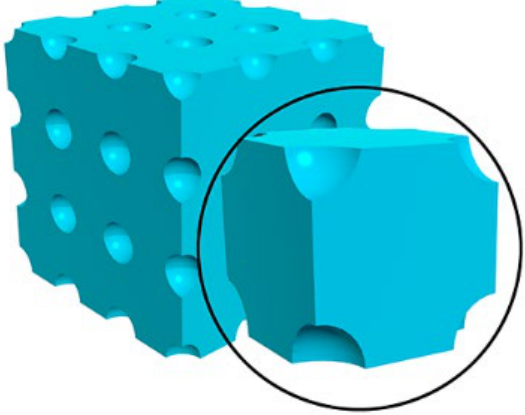
Figure 3. The schematic diagram of spherical periodic porous structure.